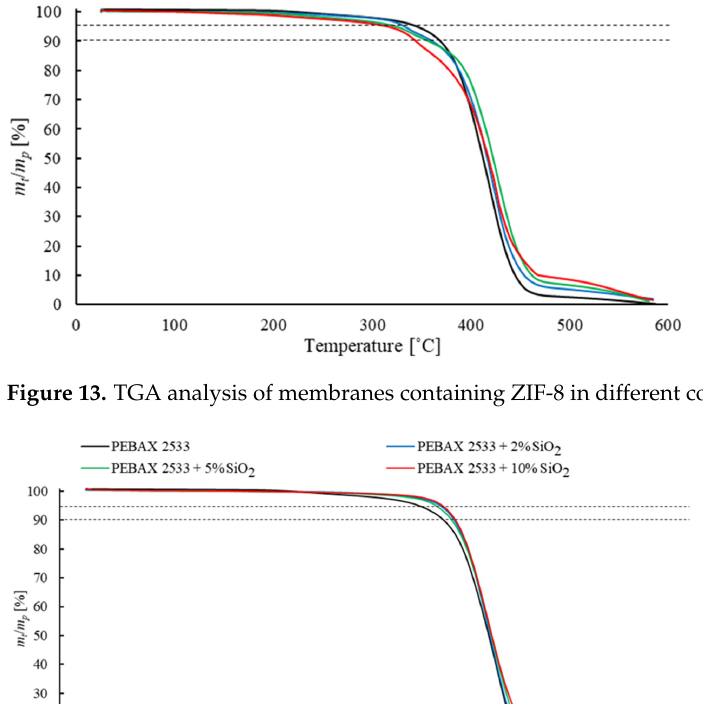
Table 1. DSC analysis results for membranes containing ZIF-8.